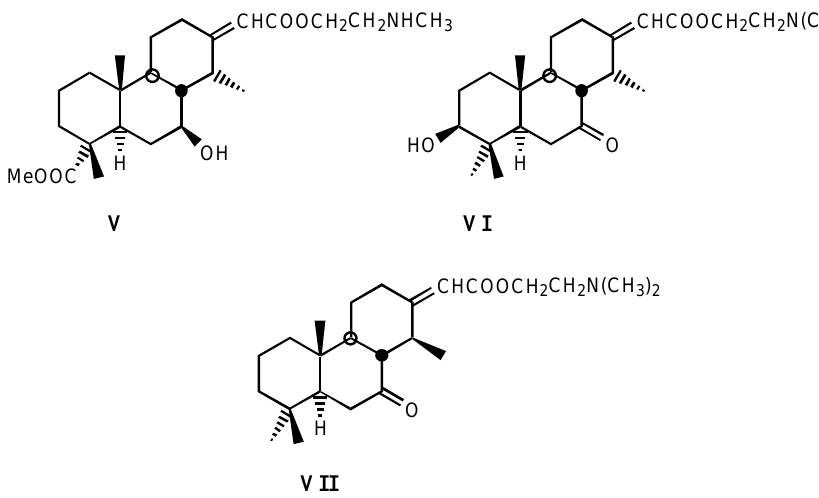
Figure 3. Structure of some of Erythrophleum alkaloids displaying digitalis-like activity: erythrophle- ine ( V ), cassaine ( VI ) and coumingine ( VII